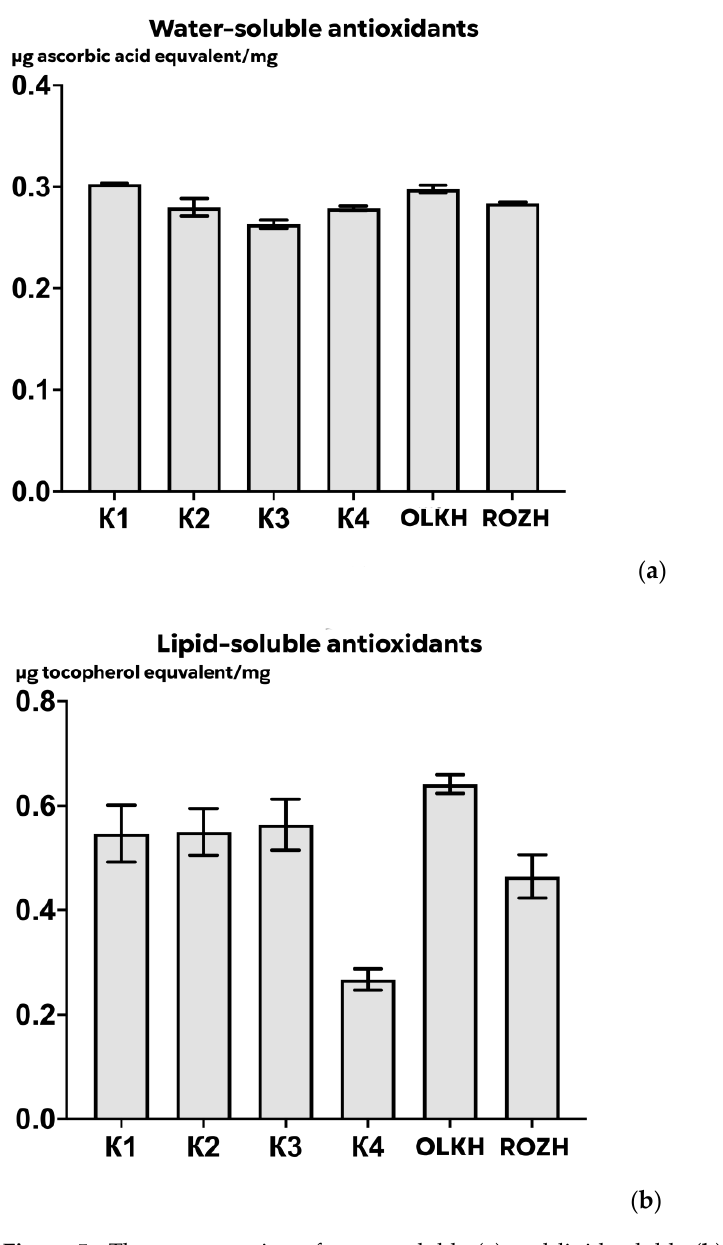
Figure 5. The concentration of water-soluble ( a ) and lipid-soluble ( b ) antioxidants in tubers of H. tuberosus growing in contaminated arias and in arias without contamination. H. tuberosus growing in contaminated arias and in arias without